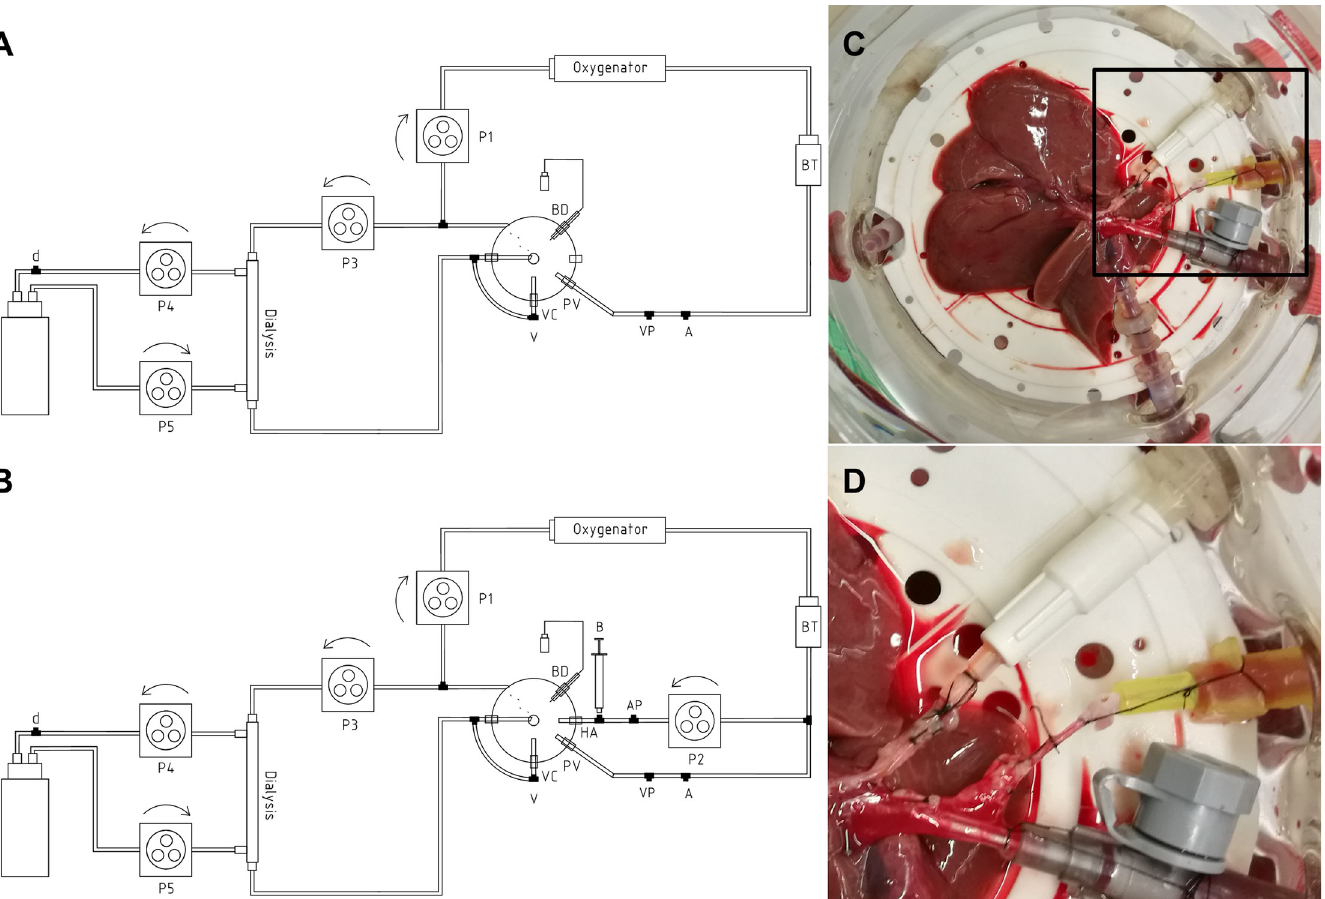
Fig 1. Perfusion setups. (A) Technical drawing of the sNEVLP setup consisting of the perfusion chamber with inlets for the portal vein (PV) and outlets for the vena cava (VC) and bile duct (BD), an oxygenator, a bubble trap (BT), a dialysis circuit and four roller pumps (P1, P3-5). Several outlets within the perfusion circuit allowed for sample collection of the arterial (A) and venous (V) perfusate and dialysate (d) and for measurement of the portovenous pressure (PV). (B) Technical drawing of the dNEVLP setup with an additional inflow for the hepatic artery (HA), a fifth roller pump (P2) and another two outlets for metamizole bolus application (B) and measurement of the arterial pressure (AP). (C) Liver in the perfusion chamber (dNEVLP) with cannulated bile duct, hepatic artery, portal vein and infrahepatic vena cava (top to bottom). (D) Close-up on cannulated hepatic artery (yellow cannula) witch patch from abdominal